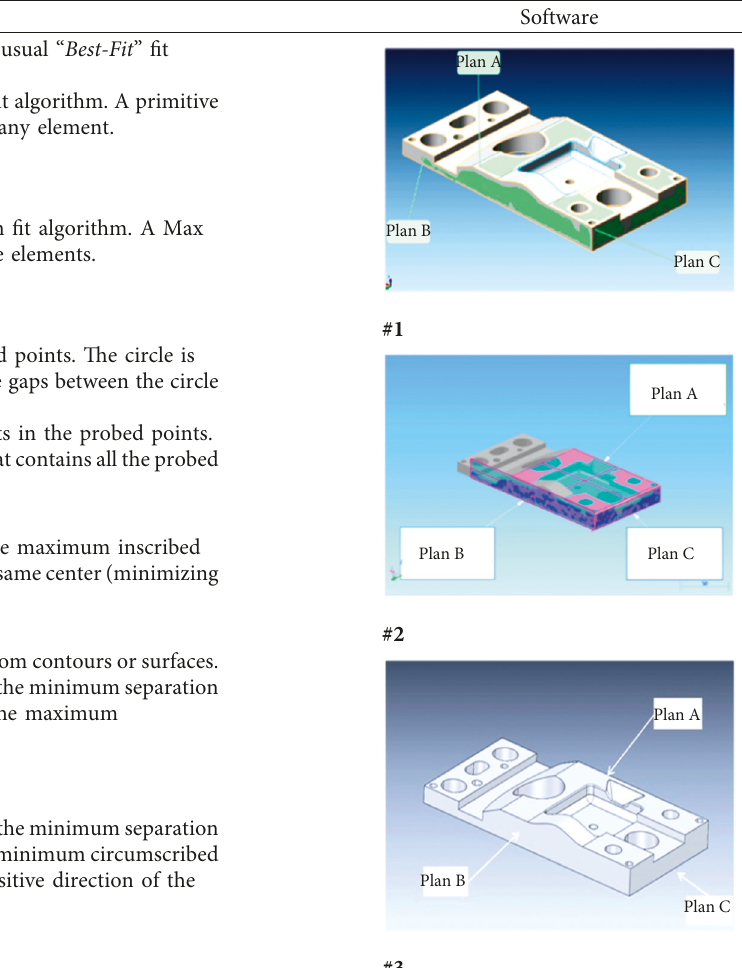
Figure 3: Elements measured for analysis. (a) Software #1. (b) Software #2. (c) Software #3. Table 1: Options for three software